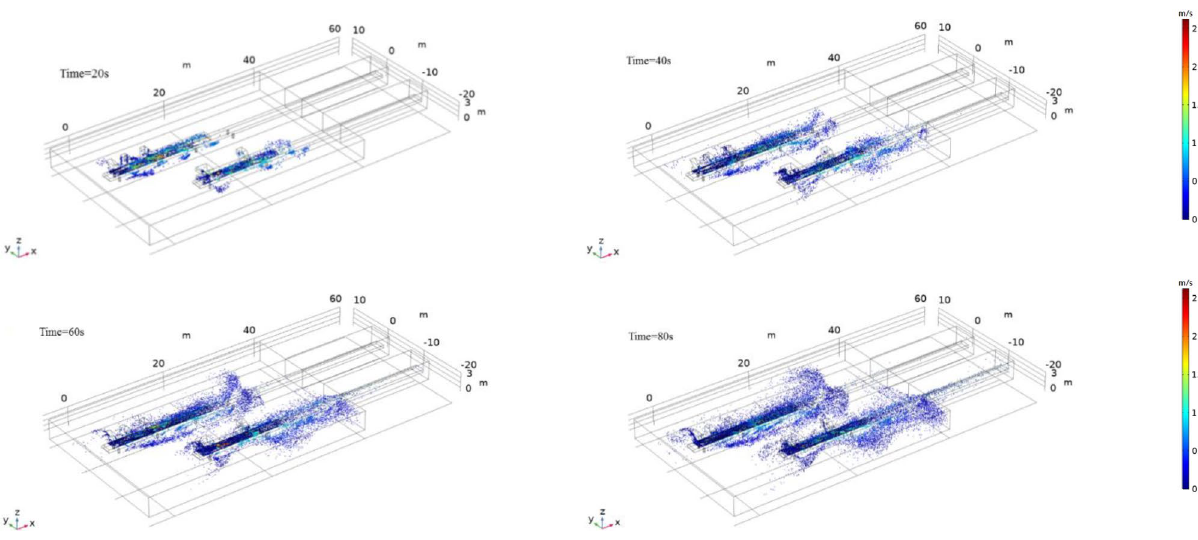
Figure 5. 26 Particle diffusion diagram at different moments in the preparation workshop.